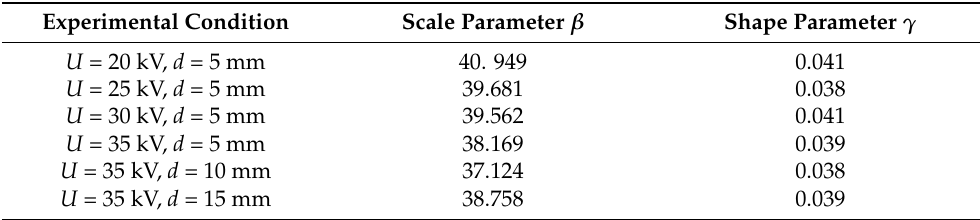
Table 6. Fitted distribution parameter of t w . Experimental Condition Scale Parameter β Shape Parameter